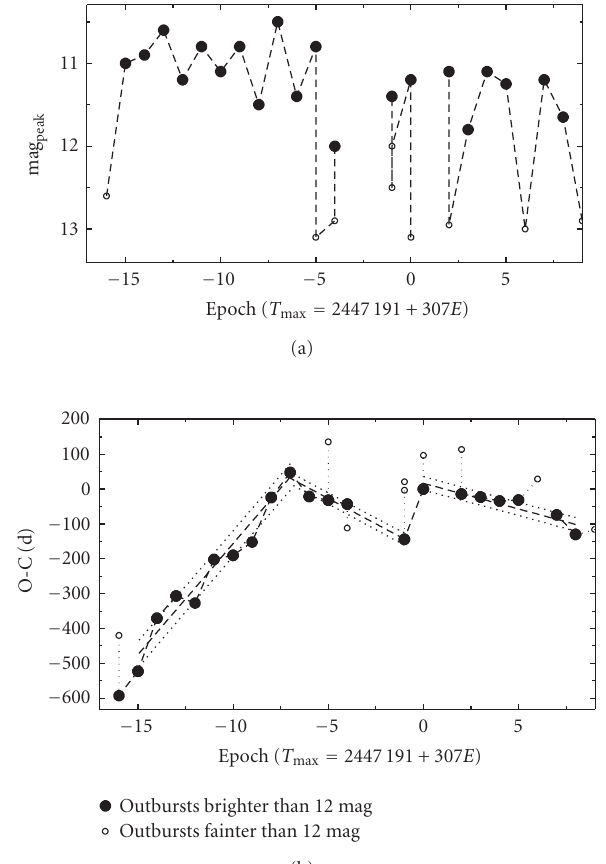
Figure 4: (a) Evolution of the peak magnitude of the outbursts in CH UMa. The bright and faint outbursts are marked by closed and open circles, respectively. (b) The O–C diagram (defined in Section 2.4) for the outbursts in CH UMa. The ephemeris is included in the title of the abscissa. The bright and faint outbursts are resolved. The O–C values of the faint outbursts are negative (positive) if they occurred before (after) the following (preceding) bright outburst. The faint outbursts are connected with the bright outburst, having the same epoch number, by a line for clarity. Adapted from